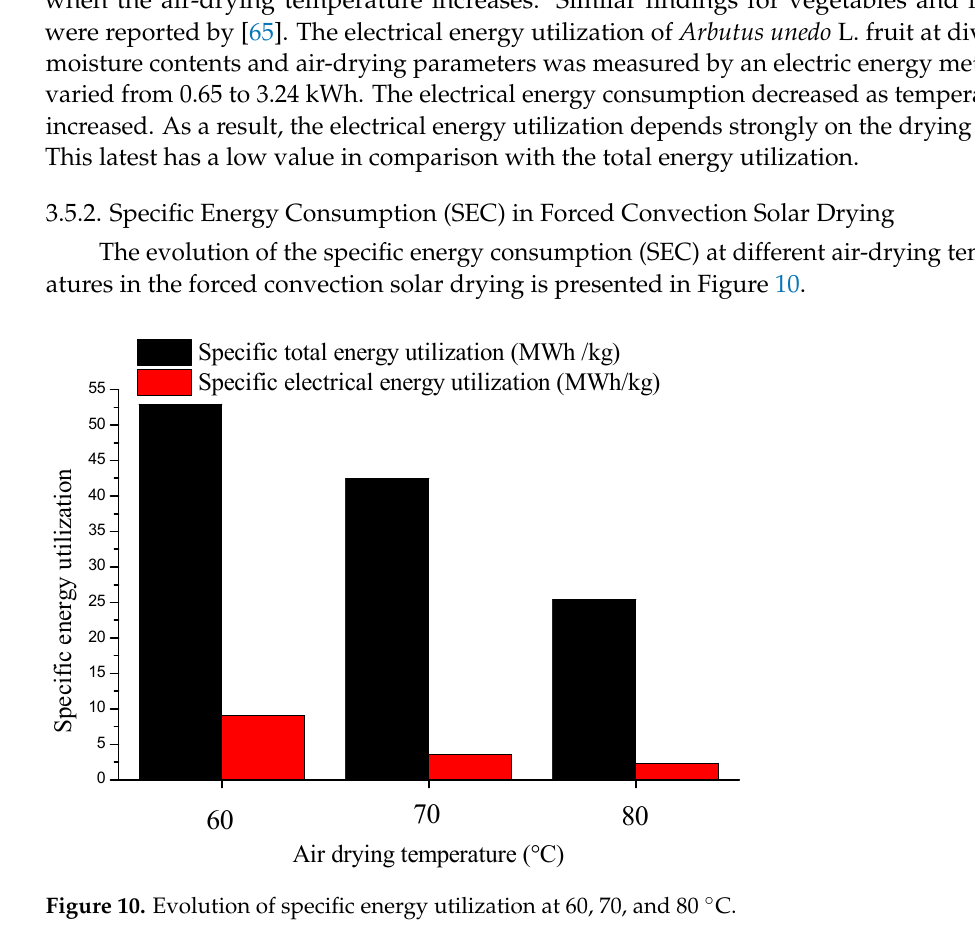
Figure 10. Evolution of specific energy utilization at 60, 70, and 80 °C.